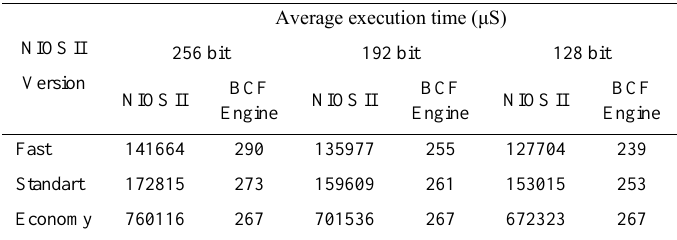
Table 12. Software and hardware running time comparation